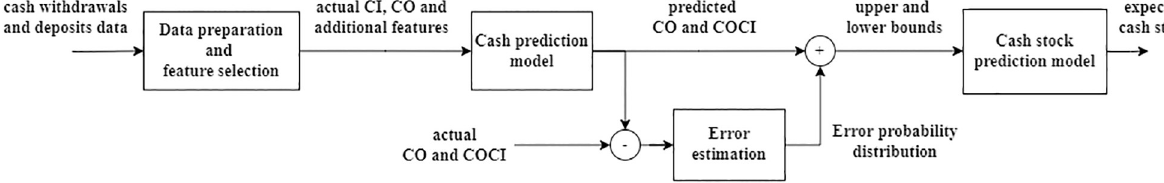
Fig 1. Proposed cash stock prediction